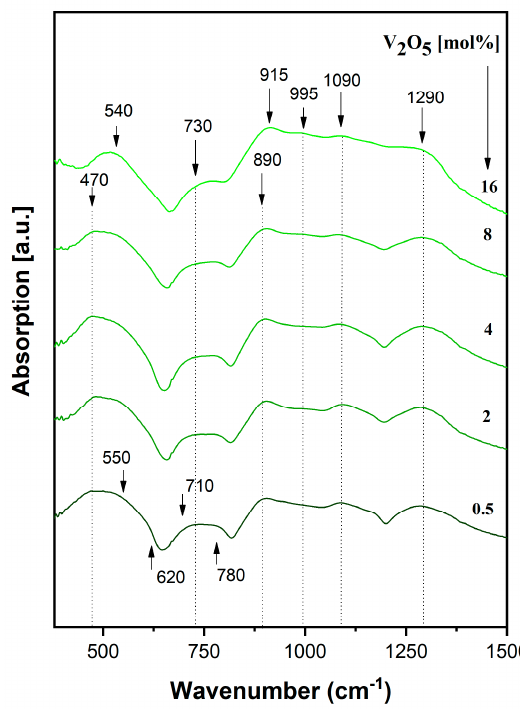
Figure 7. IR spectra of a xV 2 O 5 · (100 − x) [CaF 2 · 3P 2 O 5 · CaO] glass system.